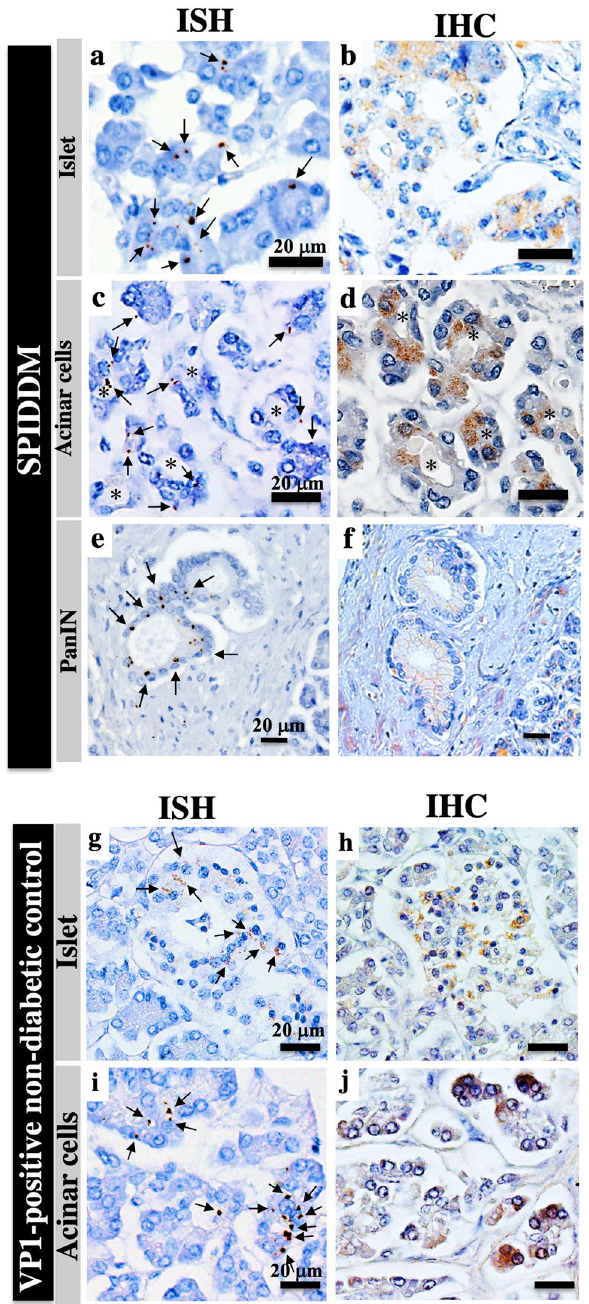
Figure 2. Detection of enterovirus (EV) probed for Coxsackievirus B1 (CVB1) RNA by in situ hybridization (ISH) and immunohistochemistry (IHC) in islets and exocrine tissues of SPIDDM and non-diabetic control (non-DC) pancreases. (a) Brown dots (arrows) are scattered in islet cells showing positive staining for CVB1 RNA by ISH in the islets of SPIDDM (Case SP2). Scale bar, 20 μm. ( b ) Serial section of ( a ) stained for VP1 in the islet by IHC (brown). ( c ) Brown dots are scattered, showing the presence of CVB1-RNA (arrows) in acinar cells changed to ADM (asterisks) of an SPIDDM pancreas (Case SP6). ( d ) Serial section of ( c ) stained for VP1 in acinar cells by IHC (brown). ( e ) Brown dots (arrows) show the presence of CVB1-RNA in a PanIN lesion in the SPIDDM pancreas (Case SP2). ( f ) Serial section of ( e ) stained for VP1 by IHC (brown) show VP1 protein residing in the same PanIN cells. ( g ) EV-RNA is detected by ISH (brown dots, arrows) in islet cells of a VP1-positive non-DC pancreas (Case non-DC17). ( h ) Serial section of ( g ) stained for VP1 in islet cells by IHC (brown). ( i ) EV-RNA (brown dots) is detected in acinar cells of a non-DC pancreas (arrows) (Case non-DC17). ( j ) Serial section of ( i ) stained for VP1 by IHC (brown). Same acinar cells as ( i ) are positive for